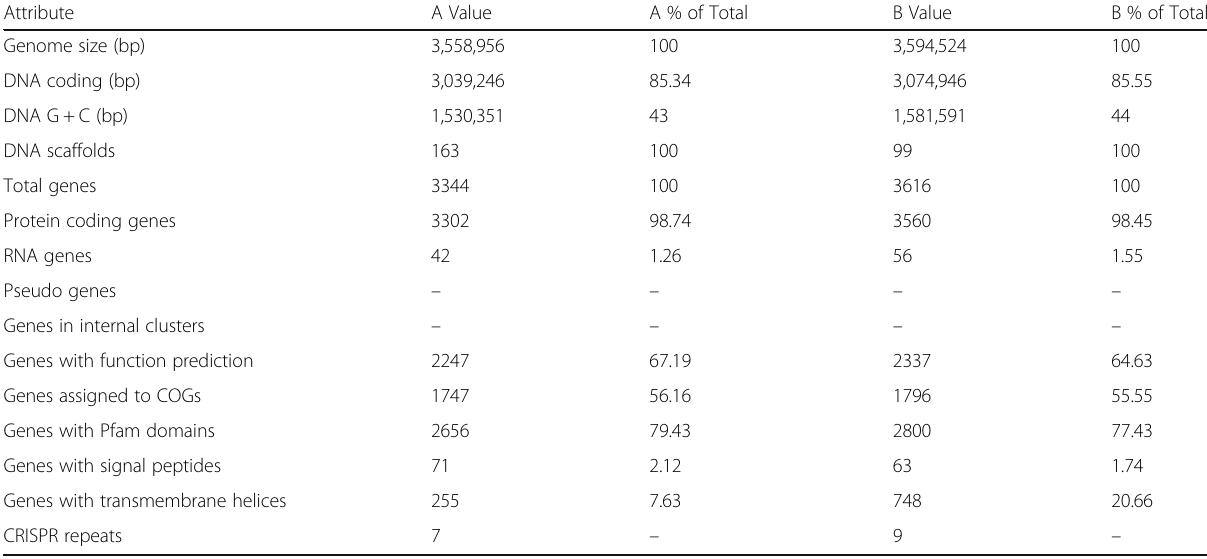
Table 4 Genome statistics of CS-508 (A) and MVCC14 (B)